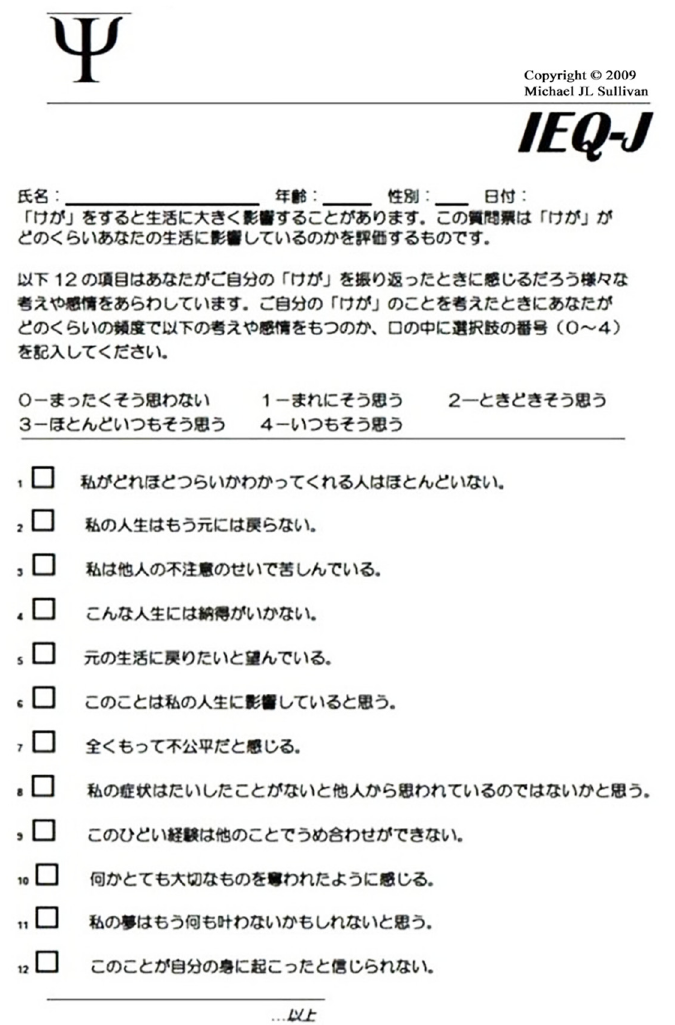
Fig 1. The Japanese form of the IEQ-J.